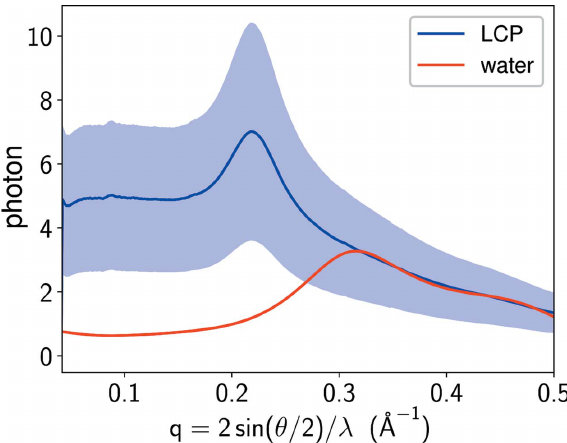
Figure 10 The scattering profiles of LCP and water, which were generated by the weighted average of the background estimates obtained in Section 2.1 and simulation, respectively. The shaded region is within one standard deviation of the average scattering profile of LCP. The large standard deviation is mainly caused by jittering of the LCP